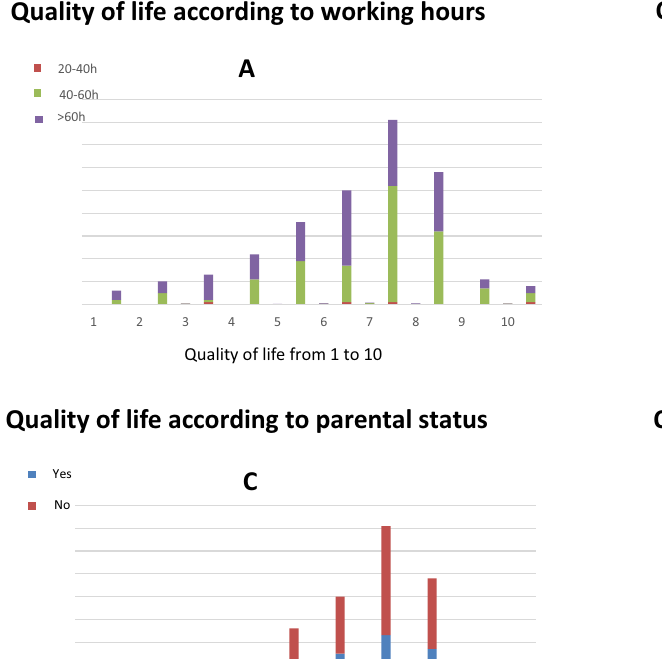
night shifts number along the year including holidays);